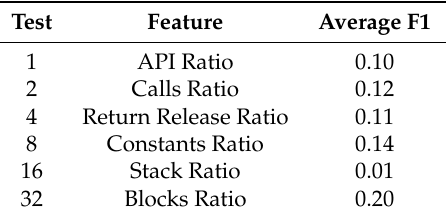
Table 13. ISFB Individual Feature Performance.